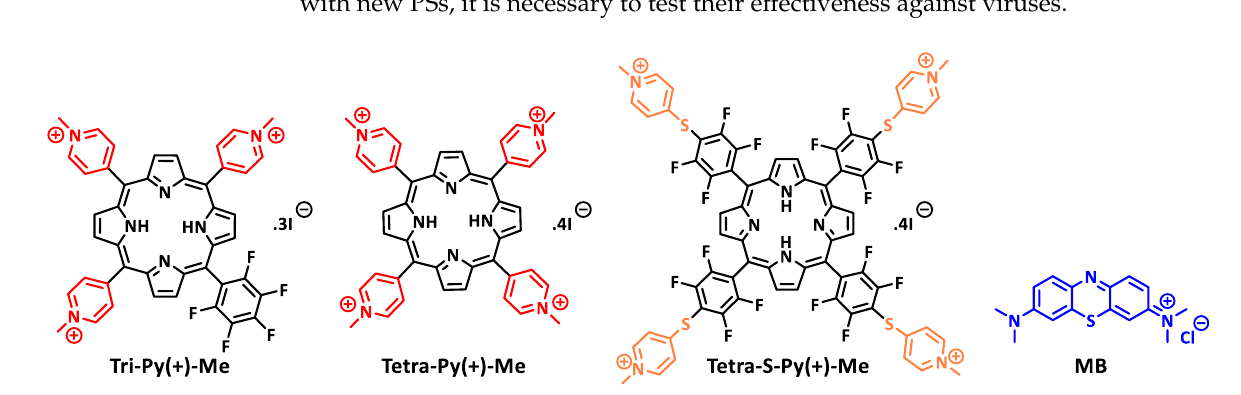
Figure 1. Chemical structures of the cationic porphyrins and of methylene blue (MB).